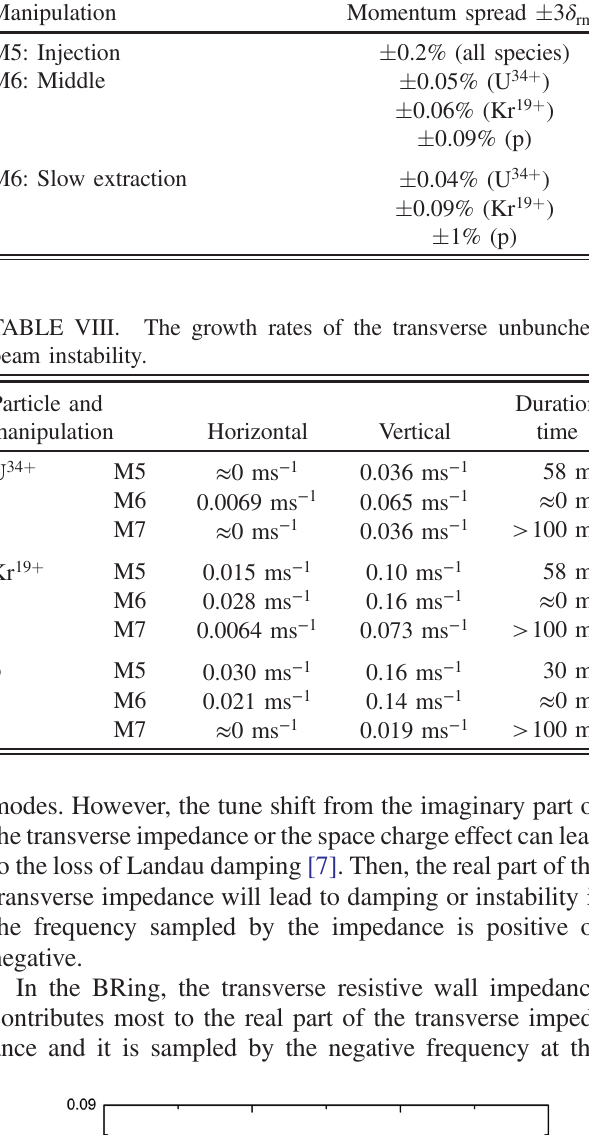
TABLE VII. The main parameters of the coasting beams. Manipulation